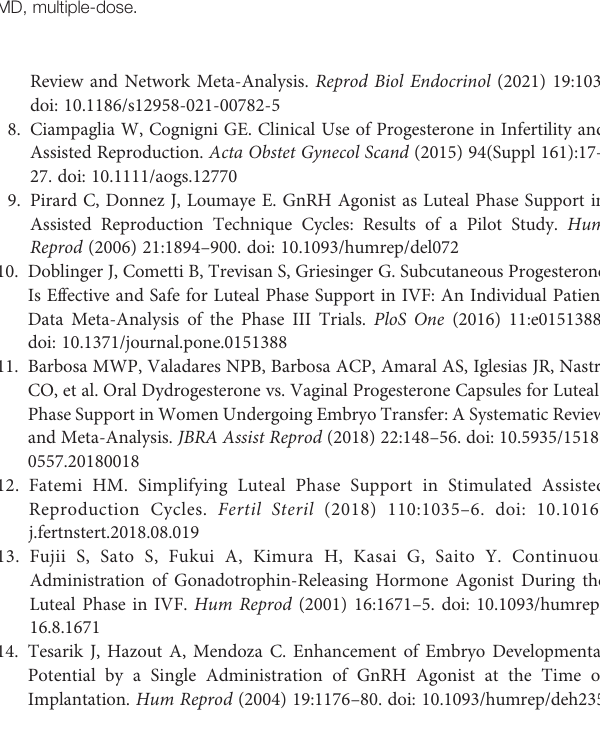
Supplementary Figure 1 | Methodological quality assessment of 16 eligible studies. (A) risk of bias summary, and (B) risk of bias graph. Supplementary Figure 2 | Meta-analysis of live birth rate. D, single-dose; MD, multiple-dose. Supplementary Figure 3 | Meta-analysis of clinical pregnancy rate. D, single- dose; MD, multiple-dose. Supplementary Figure 4 | Meta-analysis of multiple pregnancy rate. D, single- dose; MD, multiple-dose. Supplementary Figure 5 | Meta-analysis of clinical abortion rate. D, single-dose; MD,